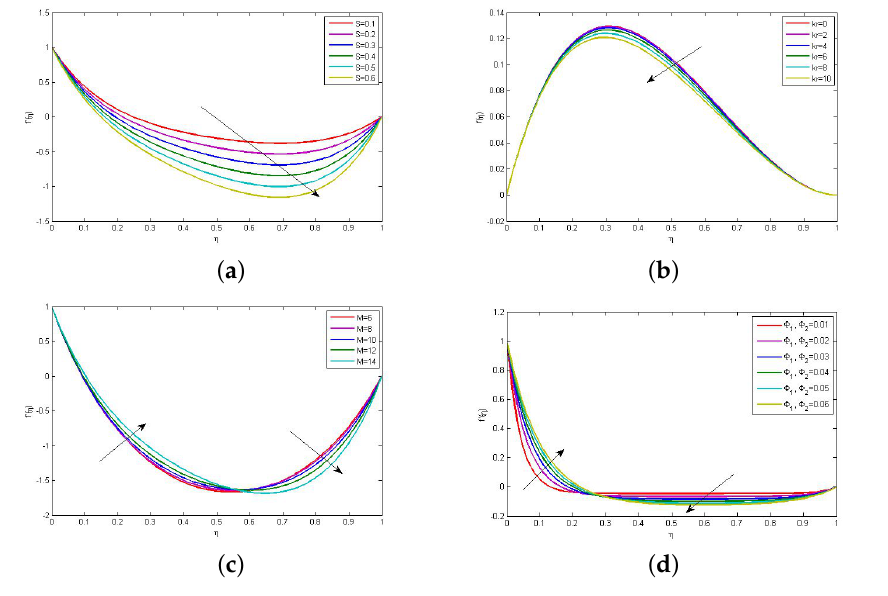
Figure 6. Effect of ( a ) S ( c ) M ( b ) kr and ( d ) Φ 1 , Φ 2 on f (cid:48) ( η )